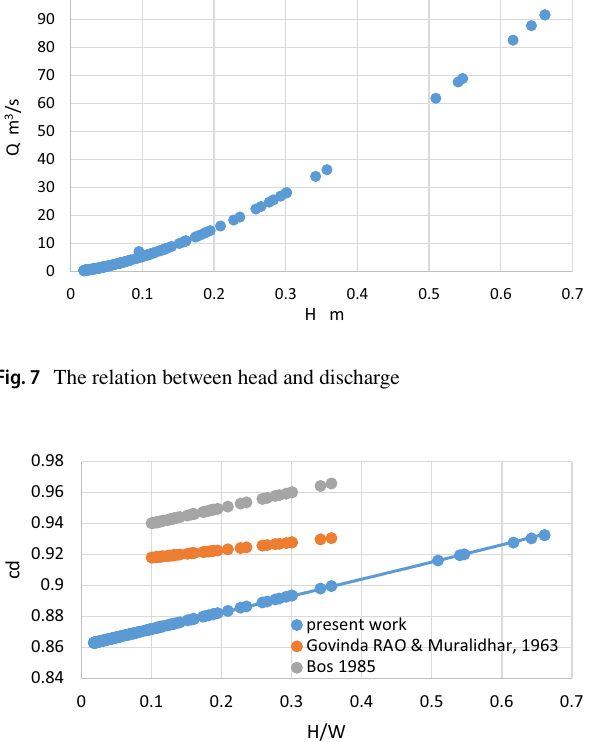
Fig. 8 The relation between discharge coefficient and head to